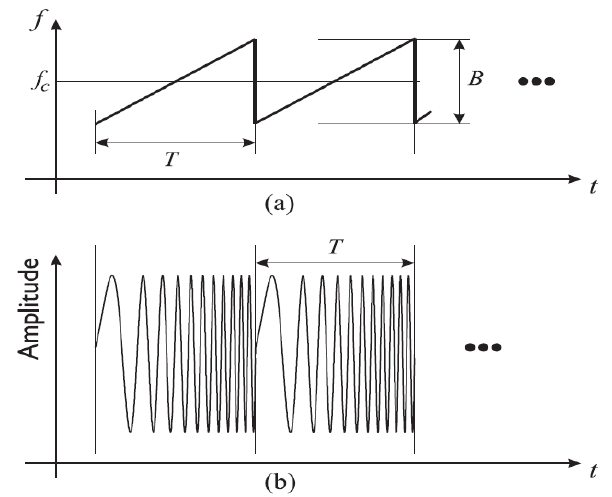
Figure 11. Frequency-modulated continuous-wave (FMCW) signal: ( a ) frequency variation over time, ( b ) instantaneous chirp signals.